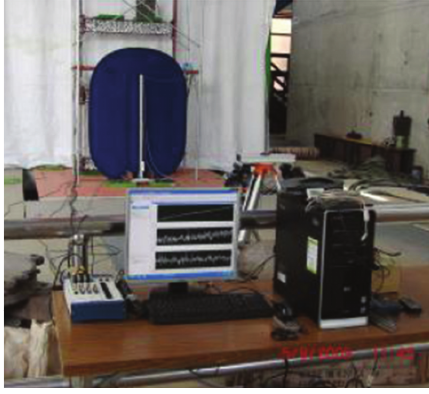
Figure 9: Normalized displacement